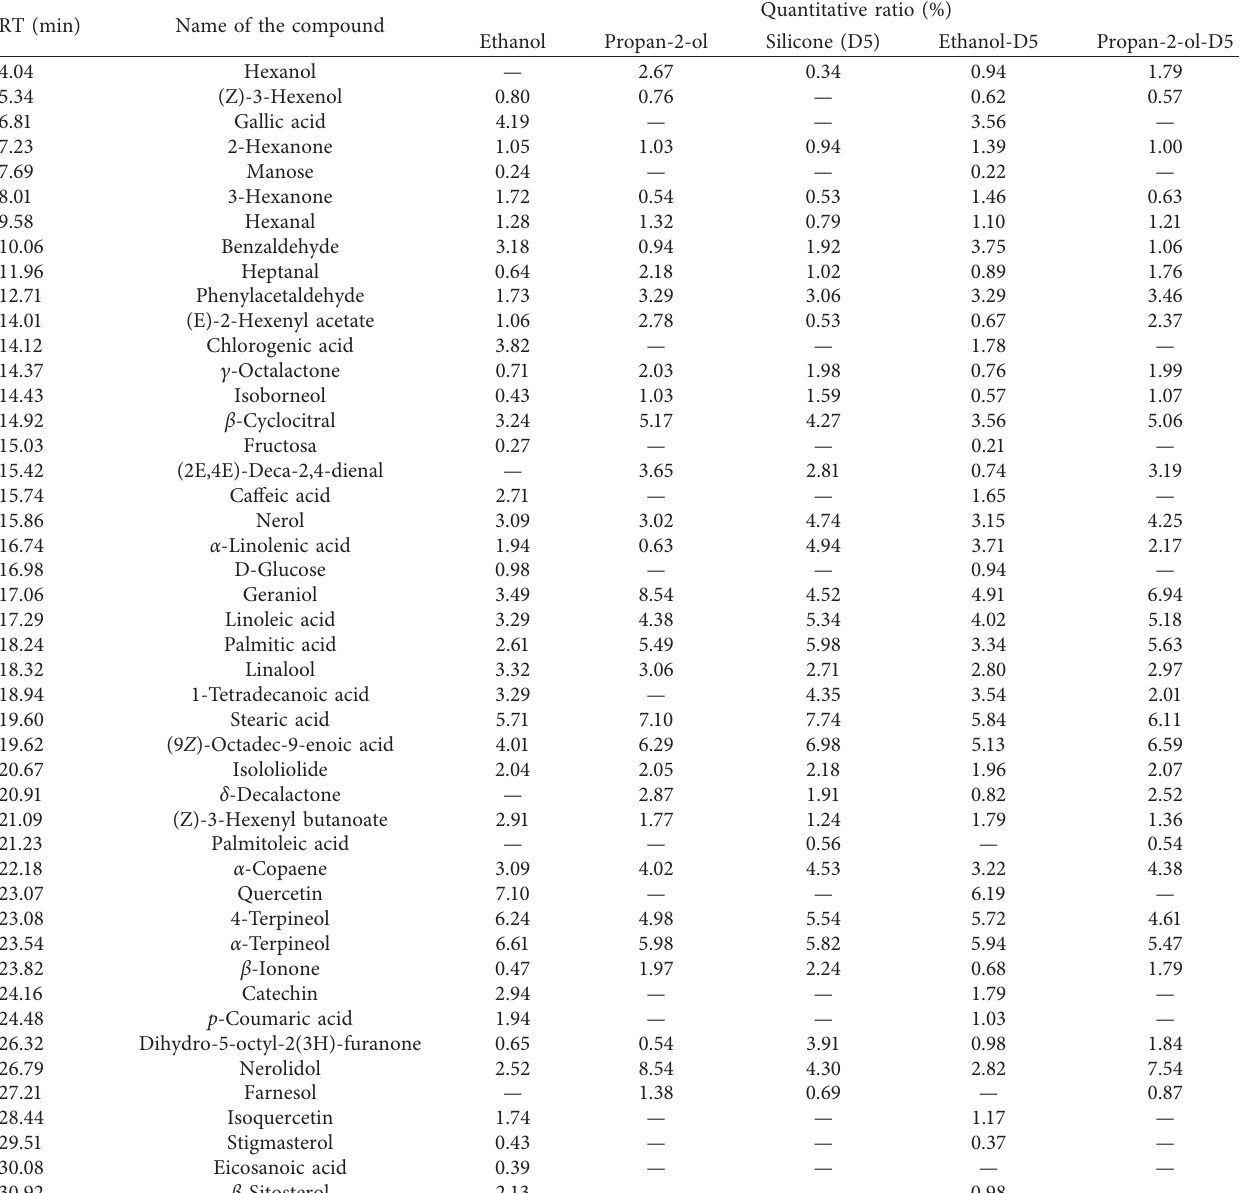
Table 1: Component profile of extracts of pomace